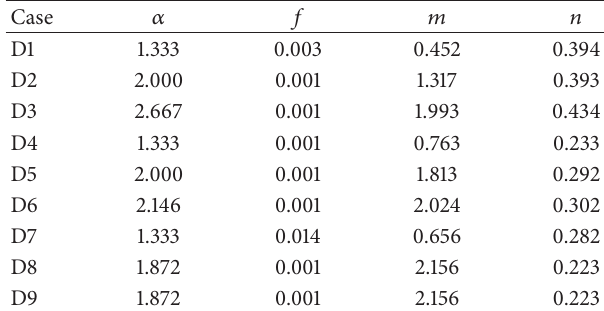
Table 3: Optimized parameters of dynamic mode of actuation of fixed-fixed microbeam